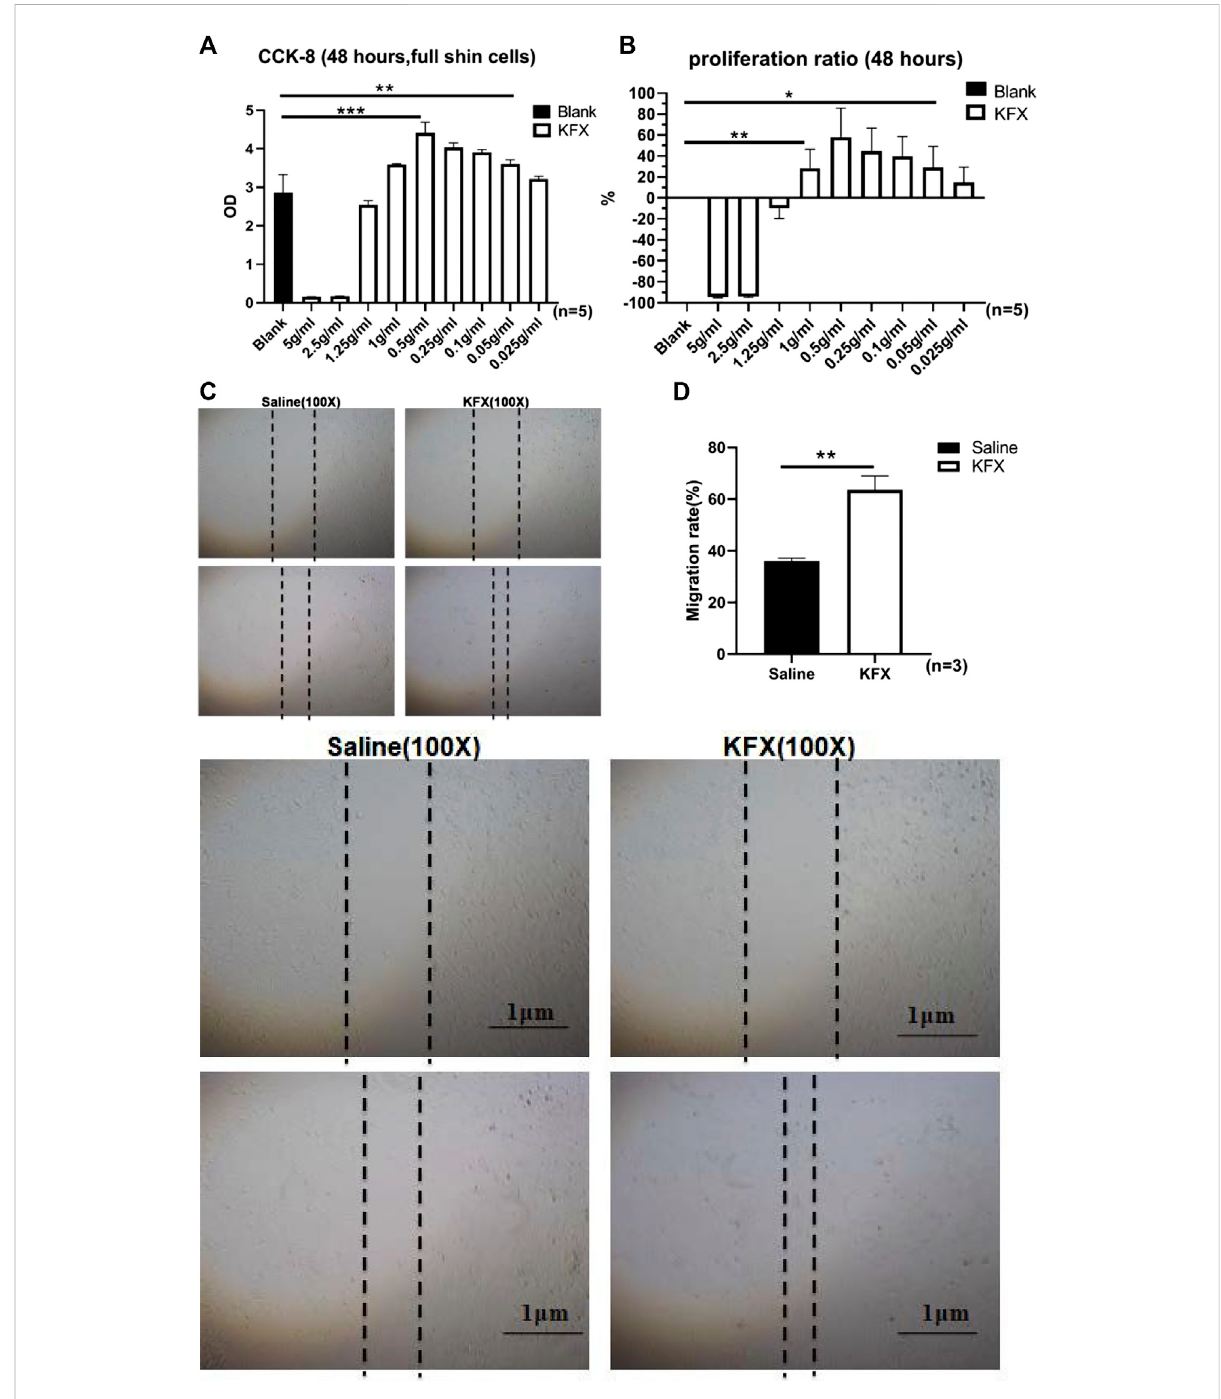
FIGURE 1 Effects ofdifferentdoses ofKangfuxin onproliferation and migrationofcutaneousepithelialcells at48 h (A,B) ODvaluesand proliferation ratio of cutaneous ECs after treatment with different doses of KFX for 48 h (C,D) Wound healing assay images and migration rate data obtained at 48 h after cell scratching. Data are shown as mean ± SD values. * p < 0.05, ** p < 0.01, *** p < 0.001 vs. control group. NS, not signi fi